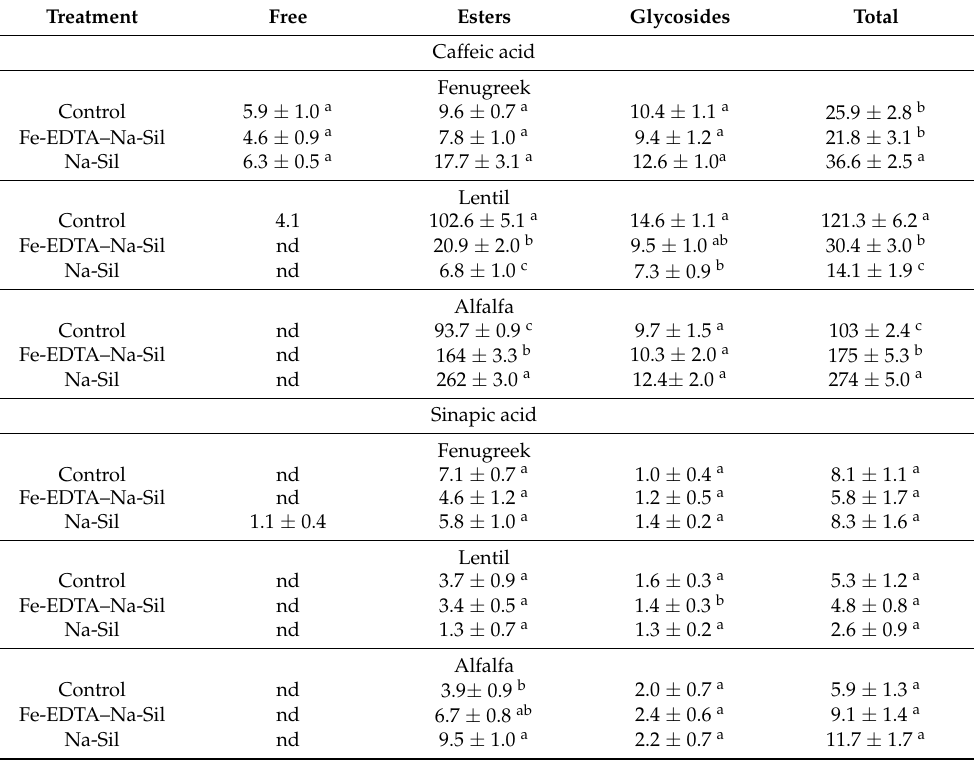
Generally, a greater effect of elicitors on flavonoid contents than on phenolic acids was observed (Table 6). Table 5. The contents of minor phenolic acids (free and released from ester and O -glycoside forms) in legume sprouts ( µ g/g − 1 DW) treated with elicitors during growth.